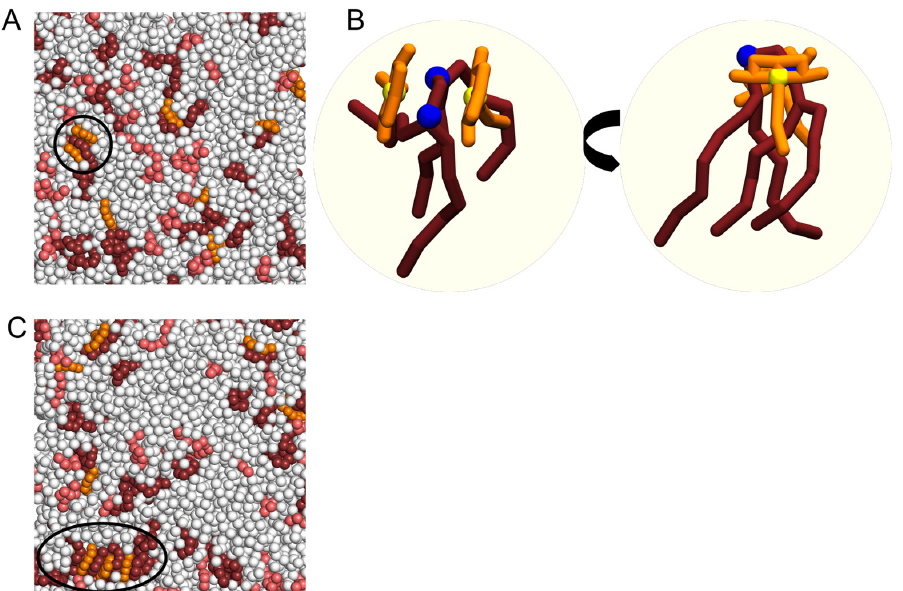
Figure 6. Formation of complexes of NAO with anionic lipids at 1:60 NAO:lipid ratio. PE is colored in white, PG—in salmon, CL—in dark ruby, NAO—in orange ( A ). Enlarged view of complex consisting of two NAO molecules and one CL molecule ( B ). Formation of heterogeneous stack composed of NAO and CL molecules ( C ). Black circles highlight sandwich-like complexes of NAO with anionic lipids.